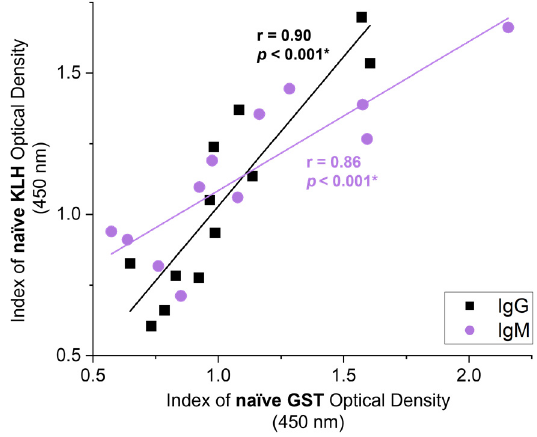
Figure 4. Correlations between the naïve antibody responses for KLH and native GST. Summated naïve serum samples from the control ( n = 6) and vaccination ( n = 6) groups in study A collected on day 0 before vaccination or challenge and analysed to assess NAb responses to KLH and native glutathione S -transferase (GST). Correlation coefficients of the mean index ( n = 4) of optical density (450 nm) for IgG NAb (black) and IgM NAb (purple) responses towards KLH and native GST are shown. Pearson’s correlation coefficient (r) and the corresponding significance value are noted on the graph next to the regression line. Significant values ( p < 0.05) are bolded and noted with an asterisk (*).